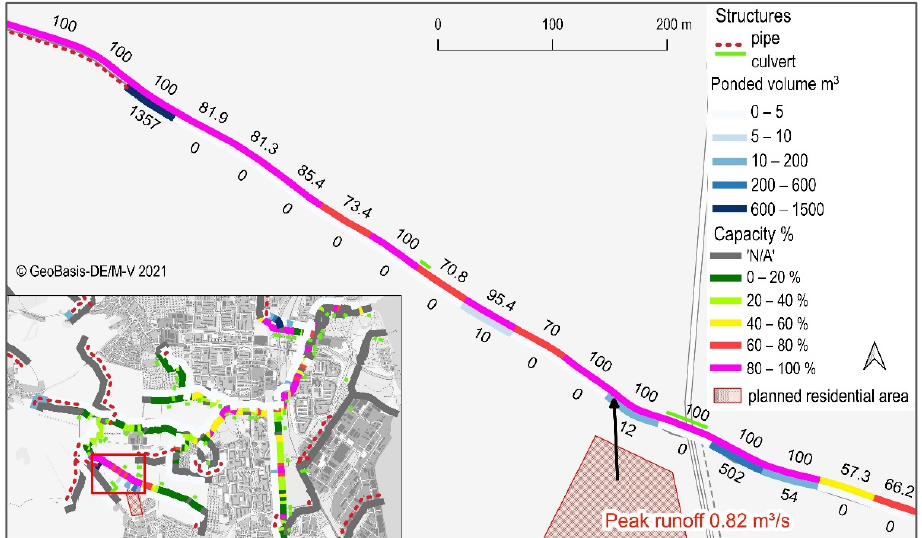
Figure 10. Maximum capacity and ponded volume in the immediate area of the discharge point for the rain event 1 h–100 a (plan state).